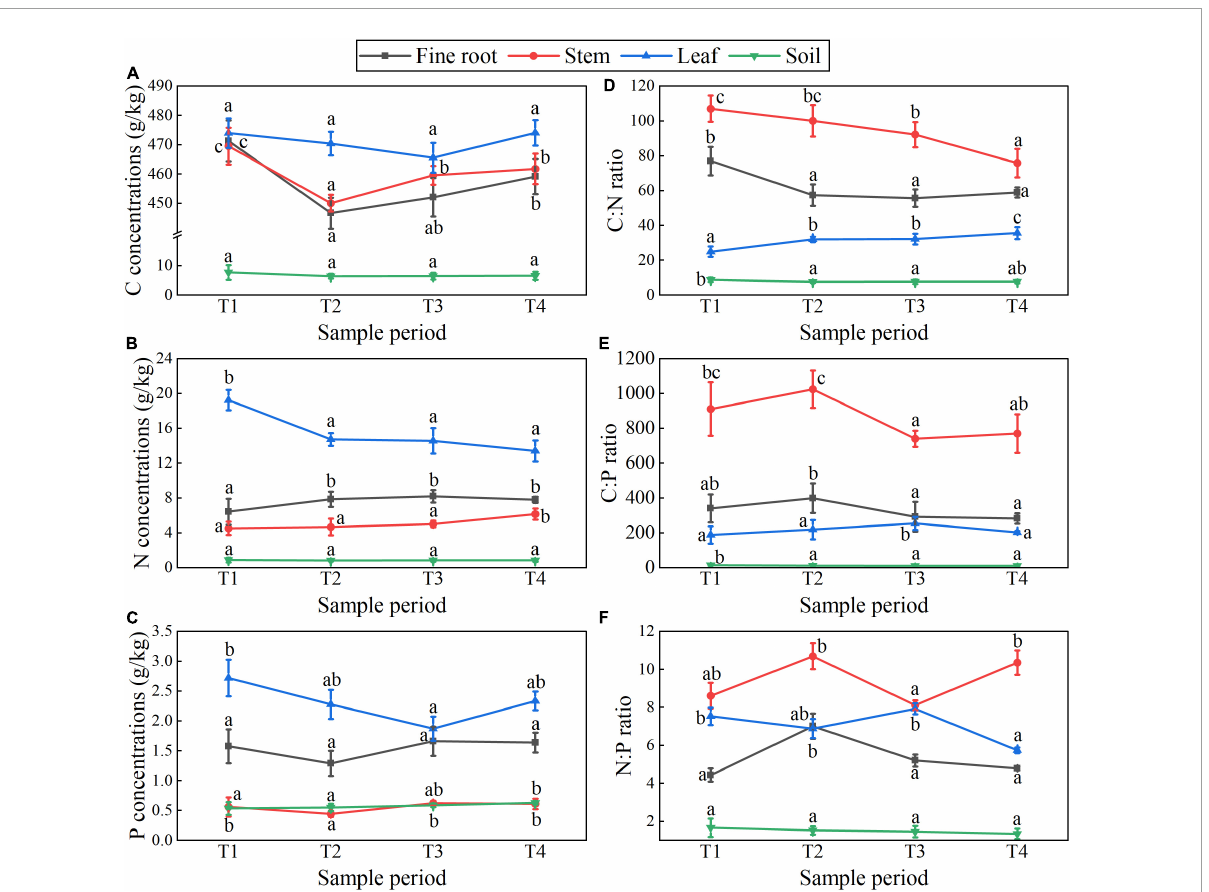
FIGURE5 T. ascendens showed C, N, and P concentrations (A–C) and stoichiometry (D–F) dynamics in fine roots, stems, leaves, and soils at different sample periods. Data shows a statistically significant difference with different lowercase letters ( p < 0.05) across sample periods (mean with standard